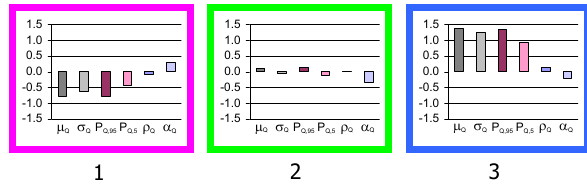
Fig. 5. Topology map of 3-cluster SOM classification of streamflow signatures